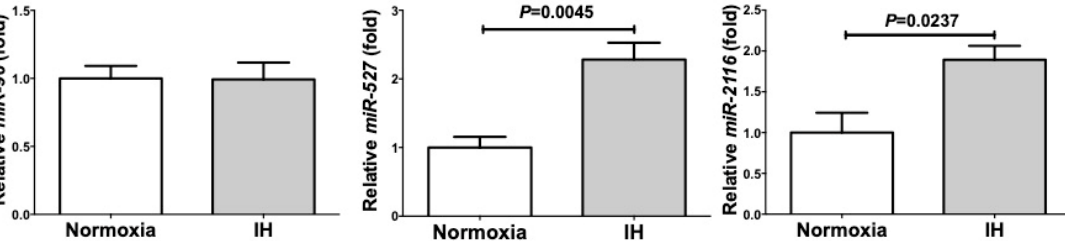
Figure 4. The levels of miR-96, − 527, and − 2116 of the IH-treated Caco-2 cells. The levels of miR-96, − 527, and − 2116 were measured by real-time RT-PCR using U6 RNA as an endogenous control. Data are expressed as mean ± SE for each group ( n = 4). The statistical analyses were performed using Student’s t -test.